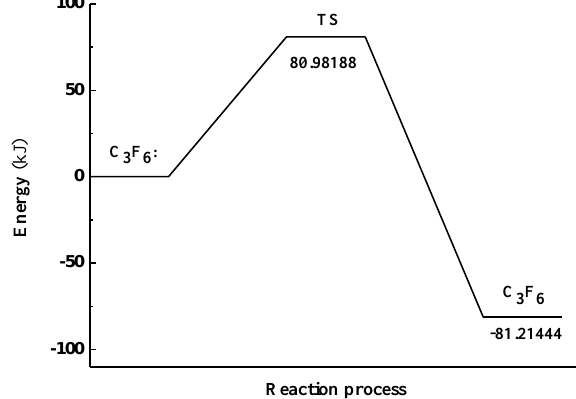
Figure 12. Reaction process of pathway B6 (TS: transition state).